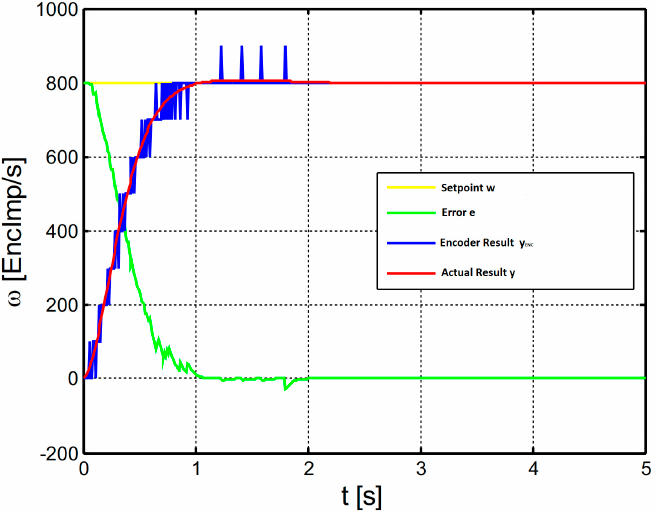
Figure 8. Simulation result of the speed controller.